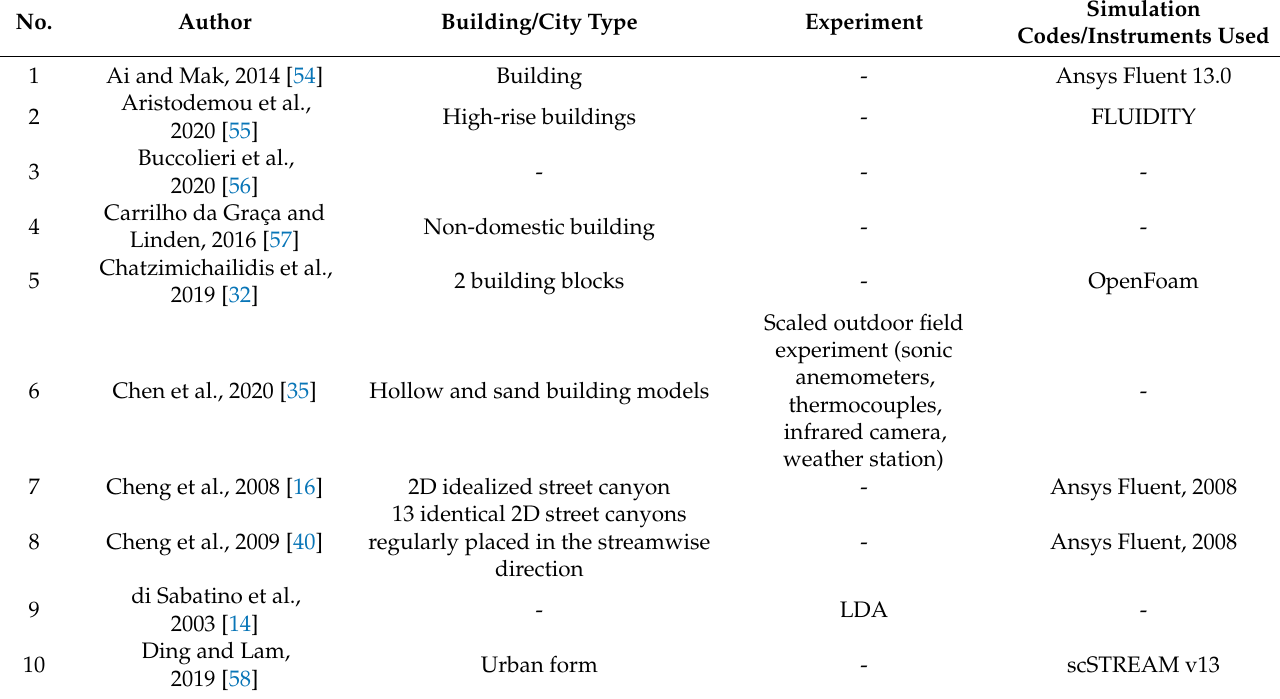
Table 3. Overview of studies of fictitious urban areas without validation comparison with experi- mental or numerical data: type of building, city, experiment and simulation